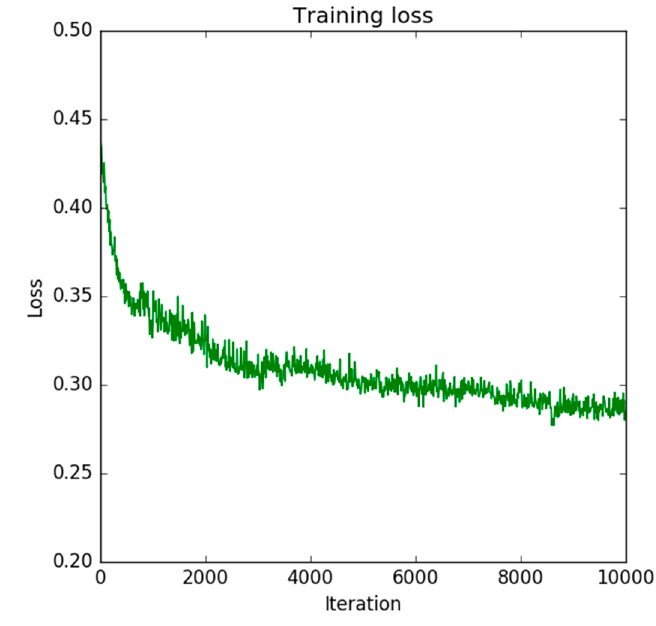
Figure 14. The curve of reconstruction loss in the method with reconstruction in Section 4.7.